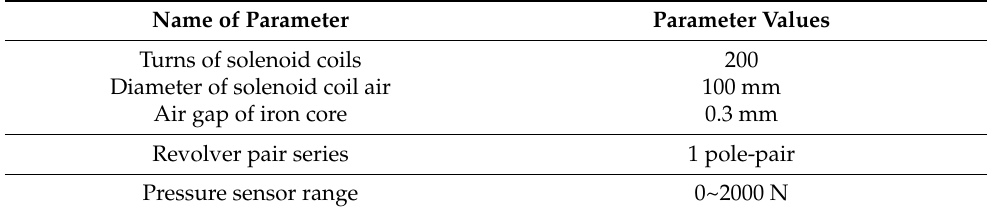
Table 1. Experiment